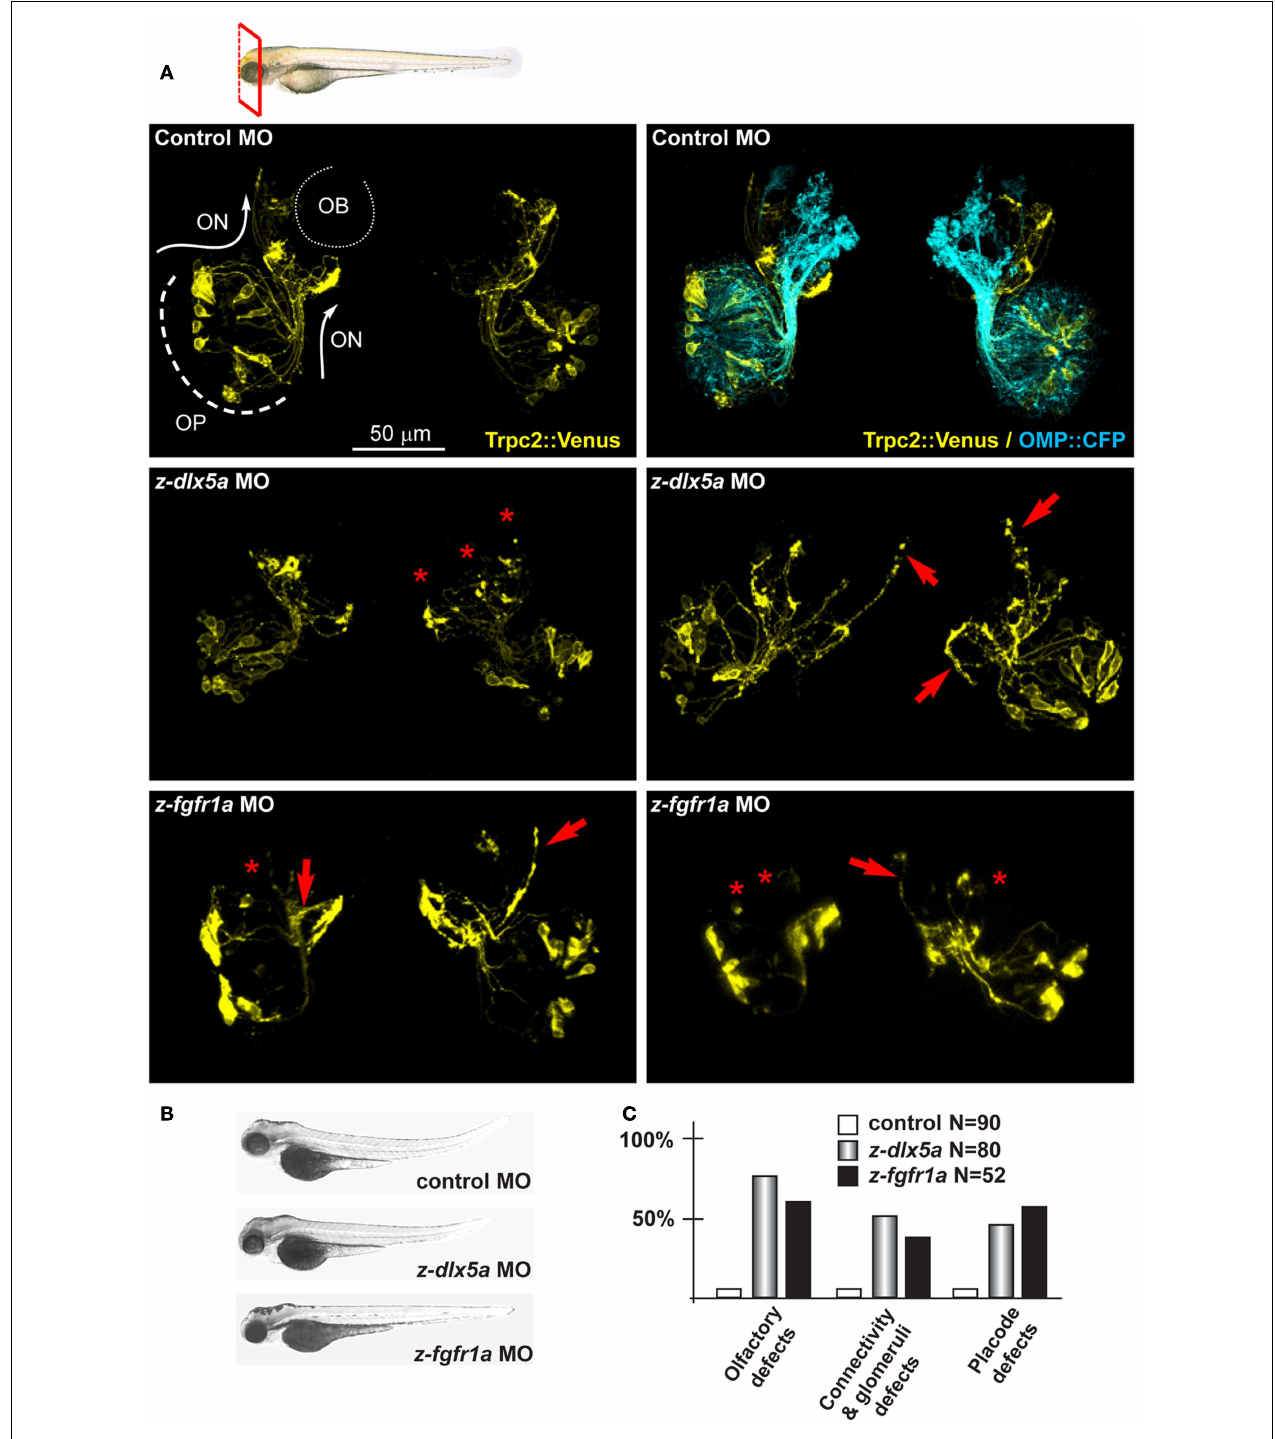
FIGURE 4 | Depletion of endogenous z-dlx5a and z-fgfr1a in zebrafish embryos, to image the olfactory axons . (A) Micrographs of Trpc2:Venus (YFP, yellow fluorescence) and OMP:CFP (cyan fluorescence) fish embryos injected with a control MO (top panels), injected with anti- z-dlx5a MO (middle panels) or injected with anti -z-fgfr1a MO (bottom panel).White arrows and lines indicate the normal axonal pathway in control embryos. Red asterisks indicate absence of glomeruli. Red arrows indicate altered axonal trajectories.